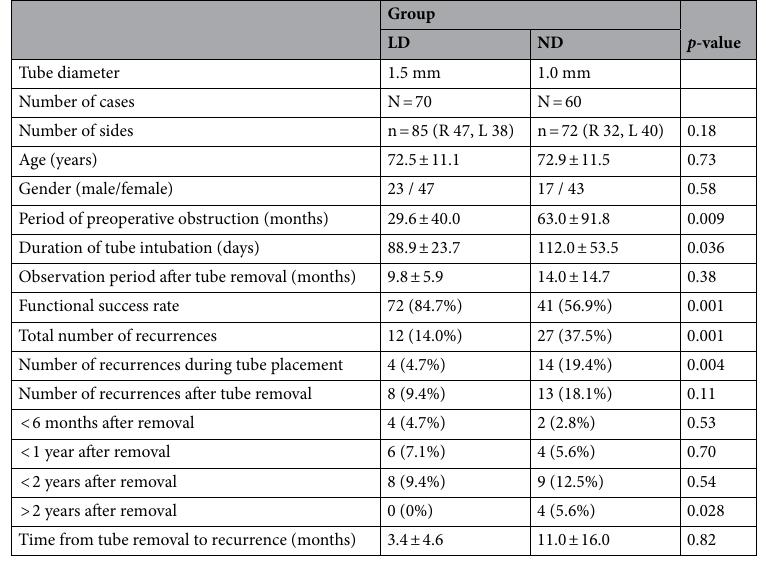
Table 1. Overview of the LD and ND groups. Data are presented as mean ± standard deviation for age, period of preoperative obstruction, duration of tube intubation, and observation period after tube removal. A p value of < 0.05 was considered statistically